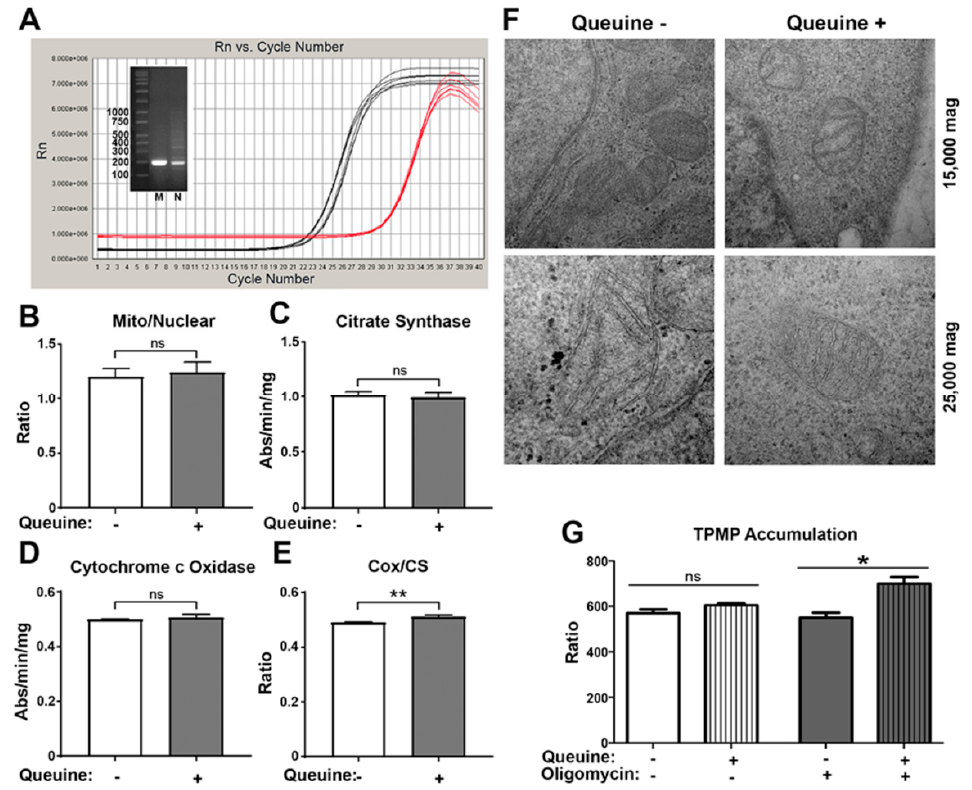
Figure 2. Mitochondrial membrane potential is a ff ected by queuine deficiency. HeLa cells were cultured for 48 h in the absence or presence of 1 µ M queuine, as indicated. ( A , B ) Total DNA was extracted and examined by quantitative PCR (upper panel) for the mitochondrial encoded cox1 gene (black trace) and the nuclear encoded ndufv1 gene (red trace) producing amplicons of 189 bp and 176 bp respectively (inset figure; M, mitochondrial; N, nuclear) and the ratio of mitochondrial number to nuclear DNA was determined. ( C–E ) Protein extracts were examined for citrate synthase and cytochrome c oxidase activity, and the ratio of both values calculated to provide an index of ETC activity to mitochondrial volume. ( F ) Following fixation, dehydration, and embedding, HeLa cells were sectioned and counterstained with uranyl acetate and lead citrate for analysis by TEM (JOEL 1210 microscope) at 15,000 × magnification (top row) and 25,000 × magnification (bottom row). ( G ) Mitochondrial membrane potential was examined by the uptake of the lipophilic cation TPMP + . Energy dependent TPMP + uptake, in the absence (left) or the presence (right) of the F 1 F O ATP synthase (F O -subunit) inhibitor oligomycin, was expressed as the accumulation ratio per mg of protein relative to TPMP + concentration in the medium according to the equation (TPMP.mg -1 protein / TPMP. µ L -1 supernatant). Mean ( ± s.d.) for triplicate samples. n ≥ 2. * p < 0.05, ** p < 0.01, t -test.